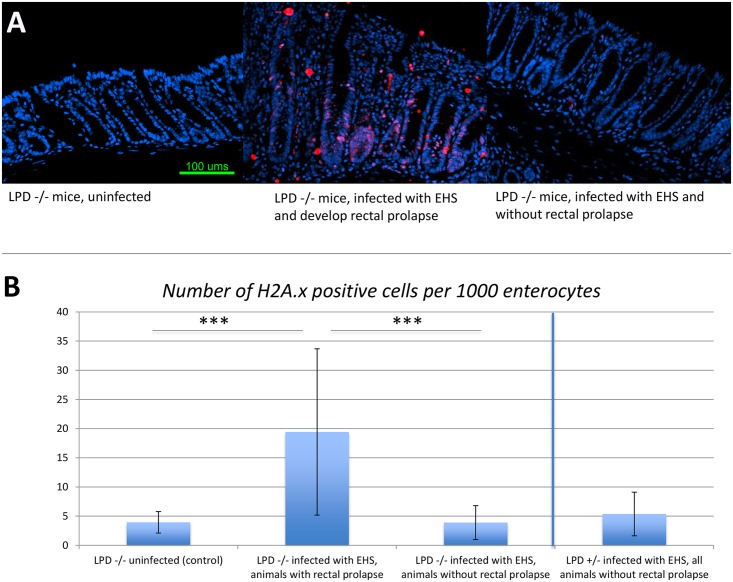
Immunostaining and morphologic analysis of DNA damage using H2AX.(A) immunostaining of DNA damage marker H2AX in LPD -/- mice without EHS infection, LPD -/- mice with EHS infection and with rectal inflammation and prolapse, LPD -/- mice with EHS infection and without rectal inflammation and prolapse; (B) morphometric quantification of average frequency of H2AX positive cells per thousand enterocytes. For each animal, total 8–10 images were obtained and analyzed. Monoclonal rabbit anti-H2AX antibody was used to label cells bearing DNA damage. The secondary antibody was goat anti-Rabbit Ig(H+L), alexa fluor 568 conjugated. Animal number, group LPD -/- control uninfected mice = 6, group LPD -/- EHS-infected with RP = 17, group LPD -/- EHS-infected without RP = 14, group LPD +/- EHS-infected = 10. *** significant at < 0.001. Magnification = 200x; bar = 20μm.